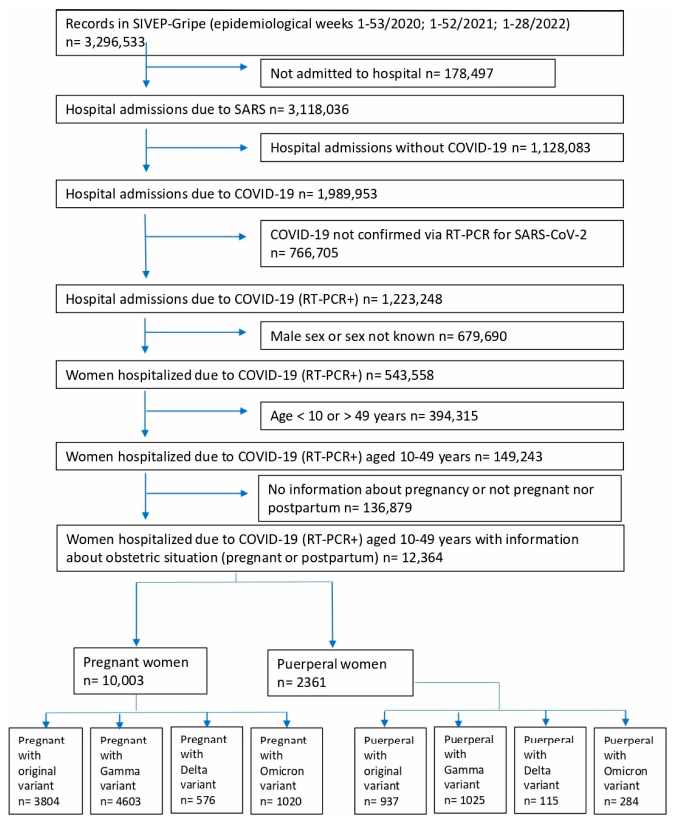
Figure 1. Flow chart of overall hospital admissions showing final counts of pregnant and puerperal women admitted with their categorization based on infection by specific coronavirus